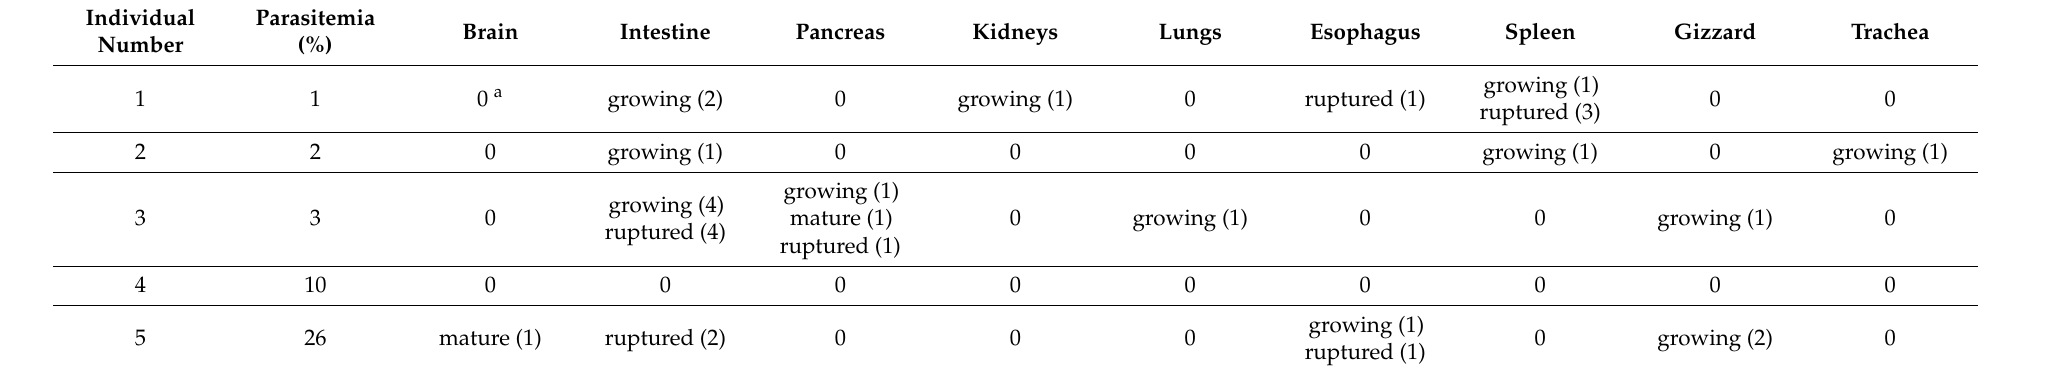
Table 1. Intensity of parasitemia and megalomeront-positive organs seen in the five dissected naturally infected Common starlings ( Sturnus vulgaris ). The number of visualized megalomeronts in histological sections (in parenthesis) and the stage of their development are shown. Note that reports of megalomeronts did not seem to be related to the intensity of parasitemia, as megalomeronts were not seen in individual no. 4, in which parasitemia was high (10%), but were present in bird no. 1, in which parasitemia was lower (1%). No megalomeronts were found in any of the individuals in the heart, liver, pectoral muscles, or the reproductive